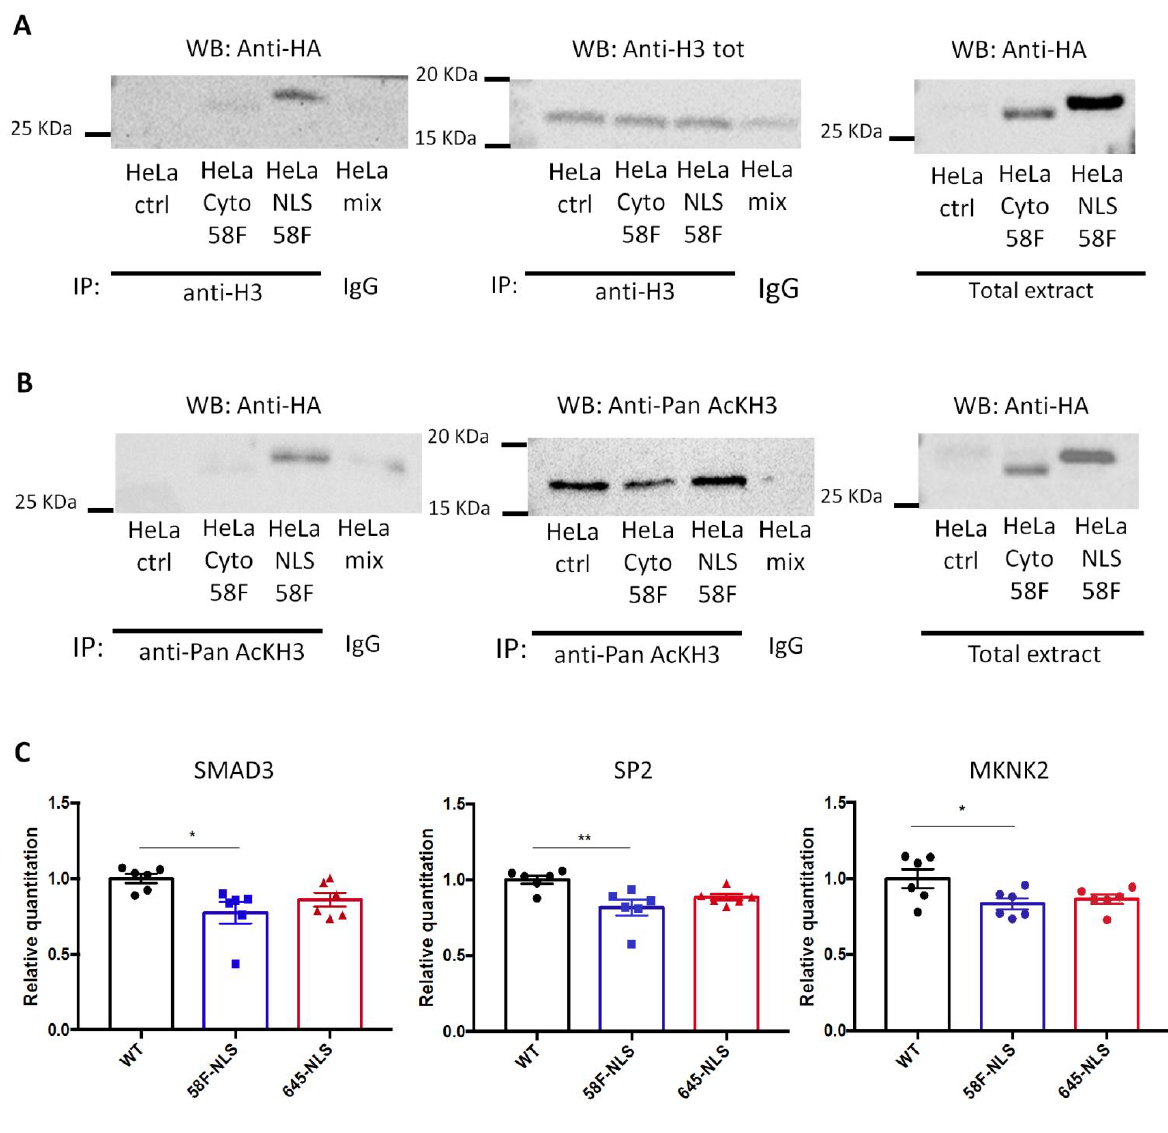
Figure 4. SscFv-58F expression in the mammalian system. ( A ) Stably transfected HeLa cells express- ing HA tagged scFv-58F-NLS (HeLa NLS 58F), HA tagged scFv-58F-Cyto (HeLa Cyto 58F), and WT HeLa cells not transfected (as control, HeLa ctrl) were used in the experiment. Lysates enriched in nucleosomes were prepared and subjected to immunoprecipitation (IP) with anti-total Histone H3 antibody (Anti-H3 Tot). Immunoprecipitated proteins were detected by western blot (WB) using the anti-HA antibody (right blot) or anti-H3 Tot antibody (middle blot). On the right the input non immunoprecipitated extract was blotted with the anti-HA antibody. ( B ) The same stably transfected HeLa cells and WT HeLa cells were used for this IP experiment. The nucleosome enriched lysates were immunoprecipitated with an antibody against the pan acetylated Histone H3 (anti-Pan AcKH3). Immunoprecipitated proteins were detected by western blot (WB) using the anti-HA anti- body (right blot) or the anti-Pan AcKH3 antibody (middle blot). On the right, the input extract not immunoprecipitated were blotted with the anti-HA antibody. HeLa mix: a mix of nucleosome ex- tract prepared from HeLa transfected with scFv-58F-NLS (HeLa NLS 58F), HeLa transfected with scFv-58F-Cyto (HeLa Cyto 58F), and not transfected WT HeLa cells (HeLa ctrl) immunoprecipitated with a specific-antibody isotype matched control immunoglobulin (IgG). ( C ) RNA was prepared from WT HeLa cells (WT), transfected HeLa cells stably expressing scFv-58F-NLS (58F-NLS), and transfected HeLa cells stably expressing scFv-645-NLS (645-NLS). qPCR analysis of SMAD3, SP2, and MKNK2 genes was performed. Data is represented as relative RNA levels of SMAD3, SP2, or MKNK2 normalized to beta actin (ACTB gene). ( n = 6 per groups, one-way ANOVA, post-hoc Tukey’s multiple comparison test: WT vs . 58F-NLS p < 0.05 *, p < 0.01 **. All other comparisons are